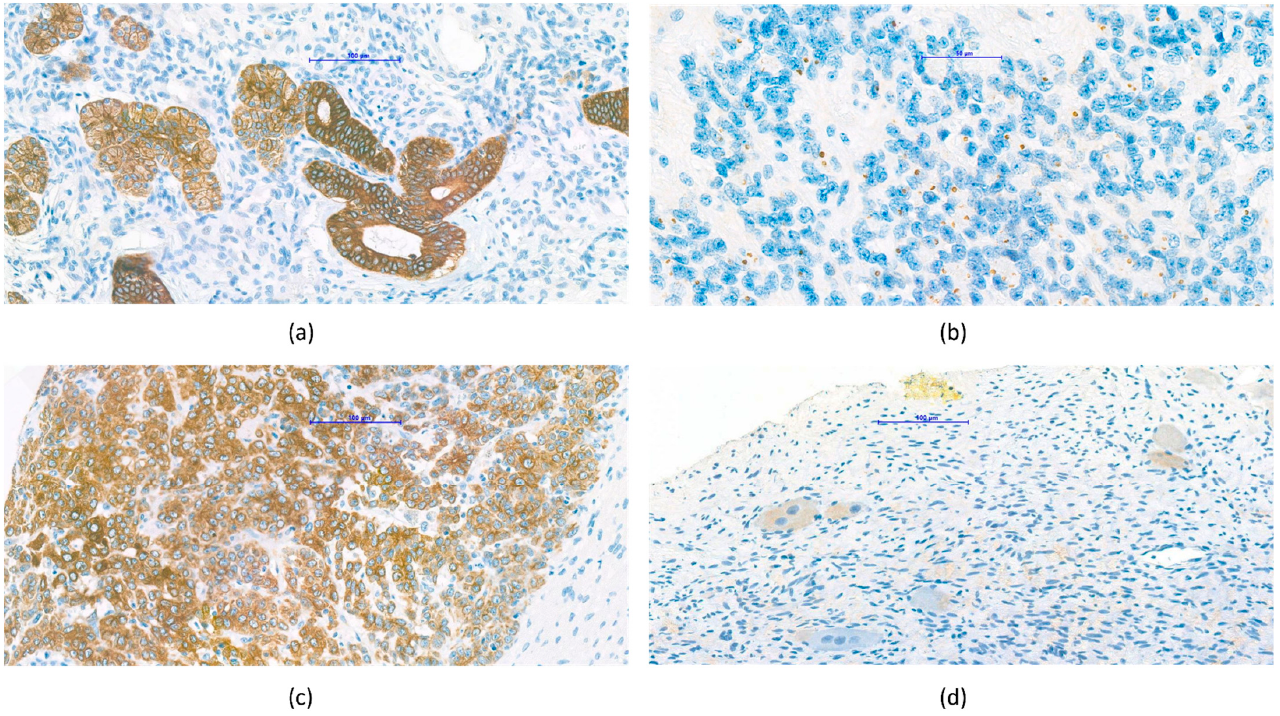
Figure 3. Representative VDR protein expression patterns in specific tumor subtypes. ( a ) Wilms’ tumor samples showed strong membrane/cytoplasmic expression, seen predominantly in the epithelial component. ( b ) Few ependymoma samples showed paranuclear dot-like positivity. ( c ) Hepatoblastoma samples showed strong, diffuse membrane/cytoplasmic VDR expression. ( d ) Ganglioneuroma samples showed positive ganglion cells.